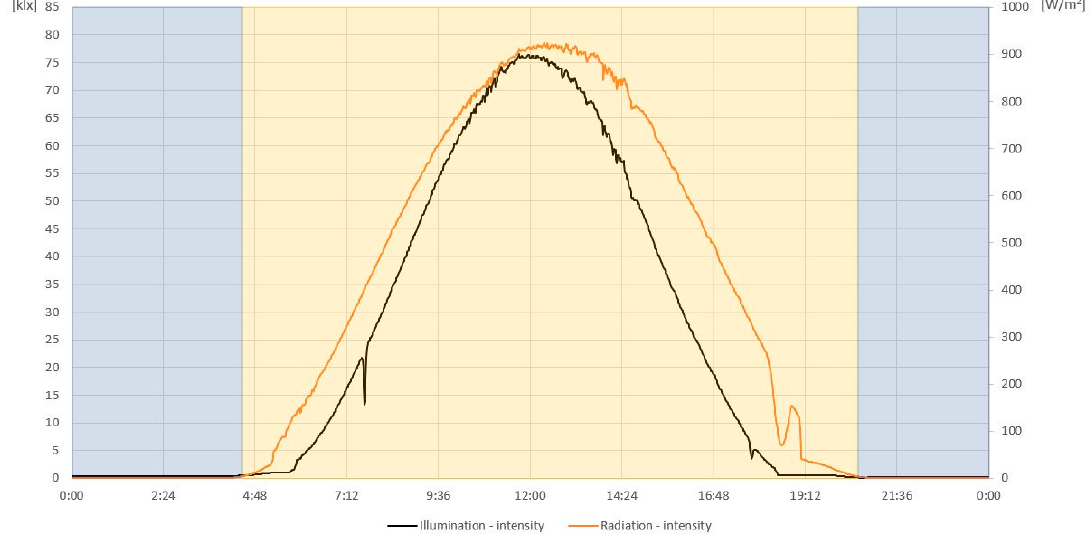
Figure 13. Illumination intensity and amount of incident solar radiation during a sunny day.